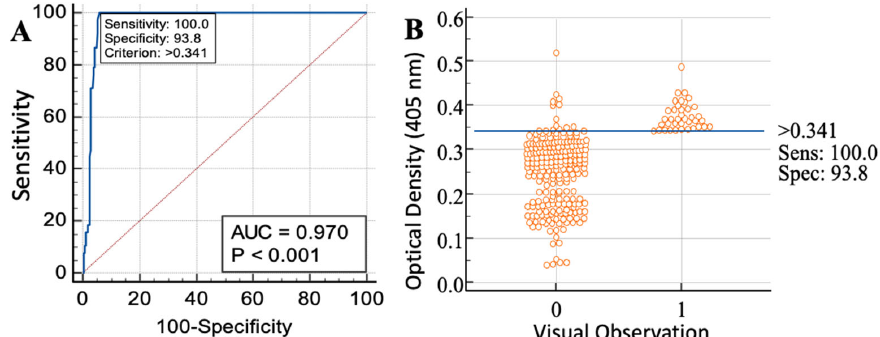
Figure 2. ( A ) Sensitivity, specificity and cut-off value of crude-antigen-based detection of Echinococcus - specific IgG antibodies in bovine sera. ( B ) Interactive dot plot for negative and positive sera. Table 2. Sensitivity, specificity, PPV, NPV, LR+, LR − and DOR values of iEgELISA. Sensitivity